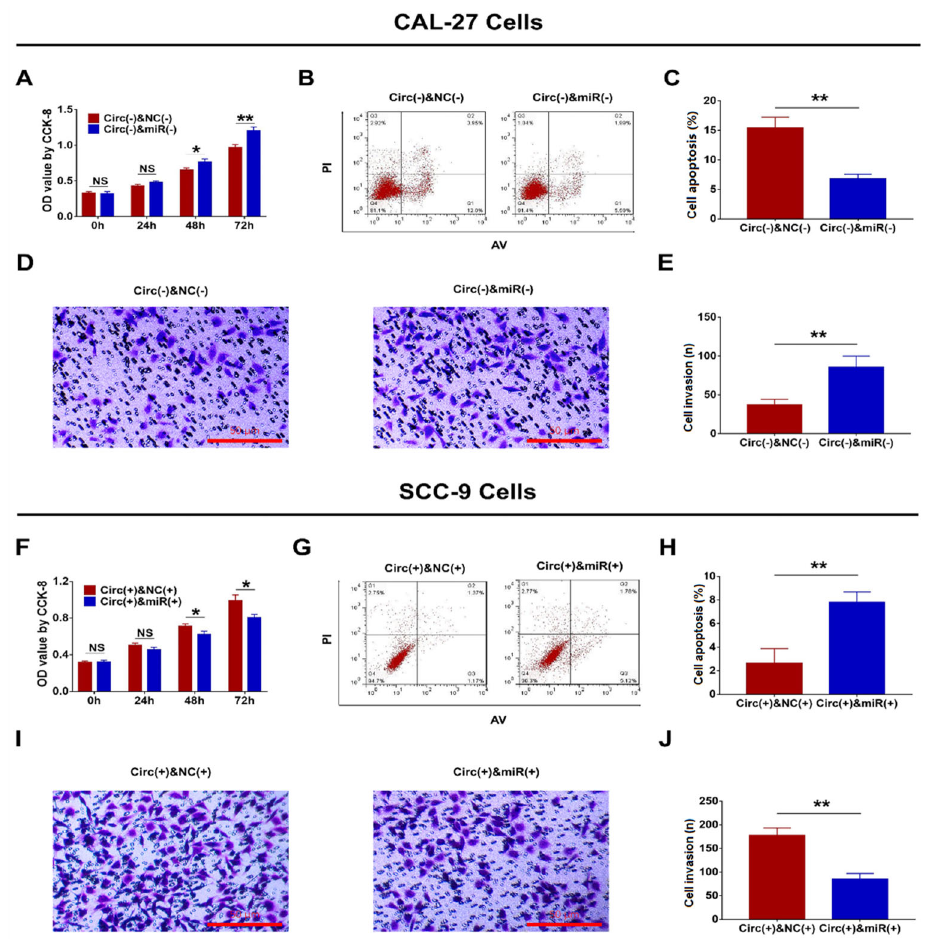
Figure 7. Comparison of cell proliferation ( A ), apoptosis ( B and C ), and invasion ( D and E ) between the Circ( – ) & miR( – ) group and the Circ( – ) & NC( – ) group (scale bar: 50 m m). Comparison of cell proliferation ( F ), apoptosis ( G and H ), and invasion ( I and J ) between the Circ( + ) & miR( + ) group and the Circ( + ) & NC( + ) group (scale bar: 50 m m). Data are reported as means ± SD. *P o 0.05, **P o 0.01 ( t -test). NS: not signi fi cant; NC: negative